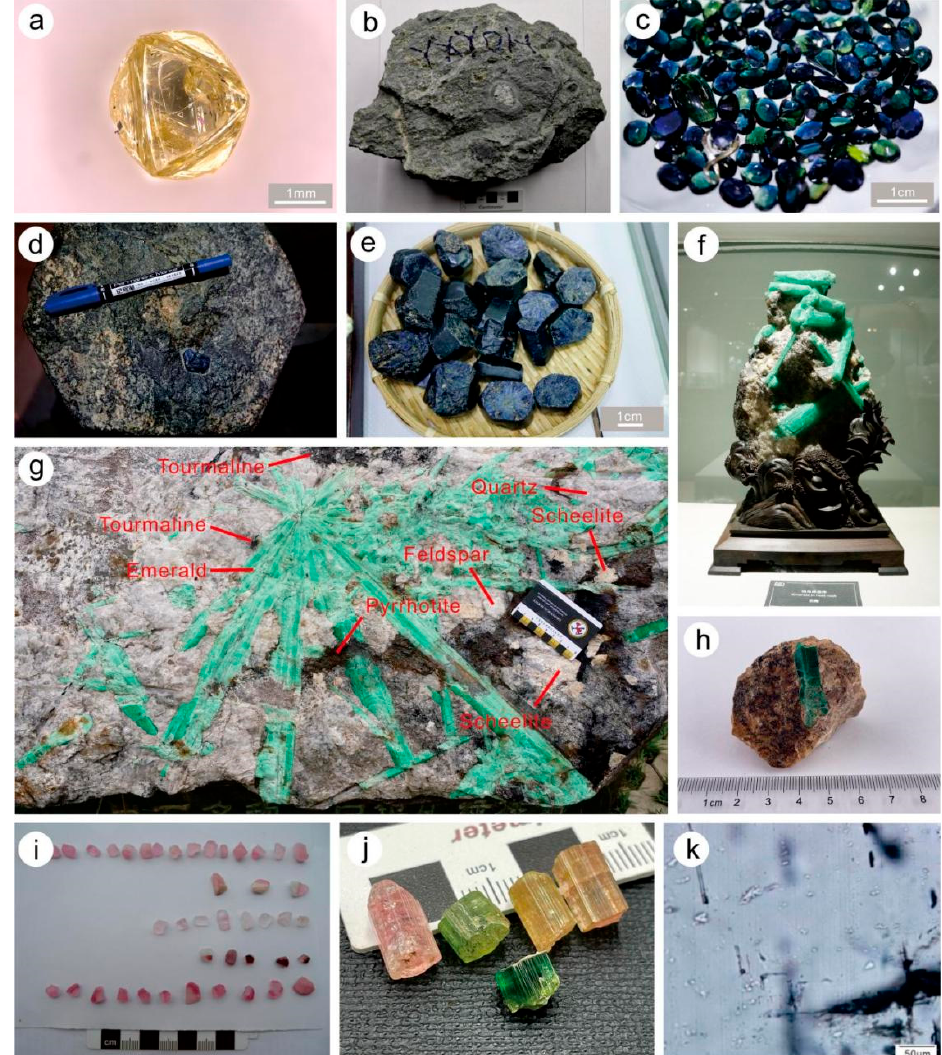
Figure 3. ( a ) The octahedral diamond mined in Changmazhuang in Mengyin, Shandong province. ( b ) The porphyritic kimberlite in Xiyu, Mengyin, Shandong province. ( c ) Sapphires from Changle, Shandong province. ( d ) Changle sapphire occurs in hexagonal columnar alkaline base. ( e ) The edges and corners of Changle sapphire crystal are mostly round and etched, and black capsules can be observed on the surface. ( f ) Dayakou emeralds from Yunnan intergrowth with quartz, calcite, scheelite. This sample measures 26 by 17 by 11cm. ( g ) Emeralds from Yunnan intergrowth with quartz, calcite, scheelite, feldspar, pyrrhotite and tourmaline. ( h ) The Davdar emerald from Xinjiang occurs in carbonaceous limestone. ( i ) Gem-grade pink tourmalines from Ailao Mountain, Yunnan. ( j ) The colorful tourmaline from Yunnan. ( k ) Needle-shaped fluid inclusion in tourmaline from Altay, Xinjiang. (Figure 3a is courtesy of Zhiyuan Chu, and Figure 3f is collected in the Geological Museum of China).